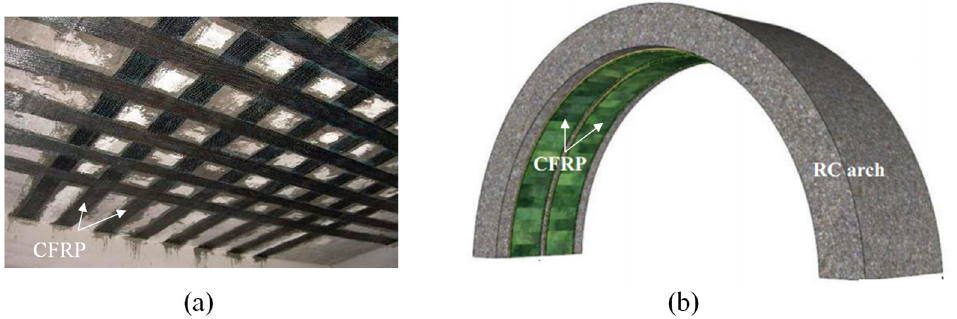
Figure 1. Reinforced interface: ( a ) plane surface; ( b ) concave curved